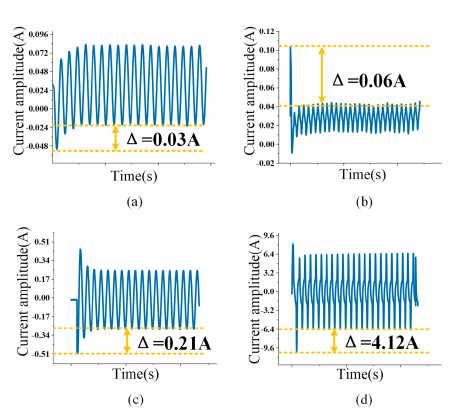
Figure 6. Starting current of different appliances. ( a ) 40W FAN, ( b ) 5W LED, ( c ) 45W IB, ( d ) 800W